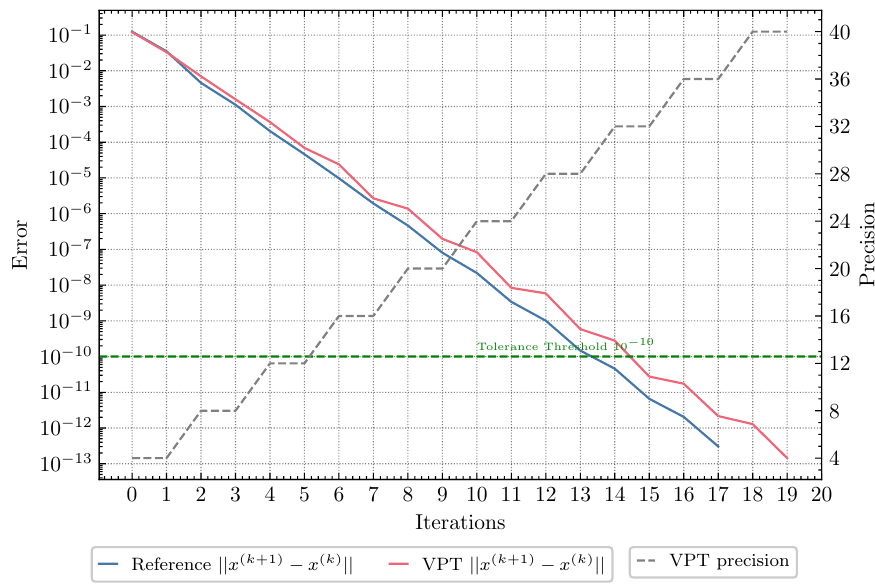
Figure A1. The convergence profile of the VPT-enabled